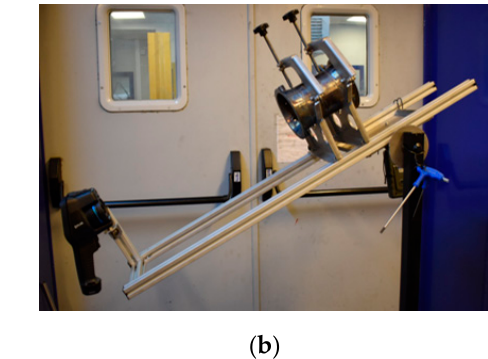
Figure 1. Test protocol to study heat losses under zero-flow conditions.